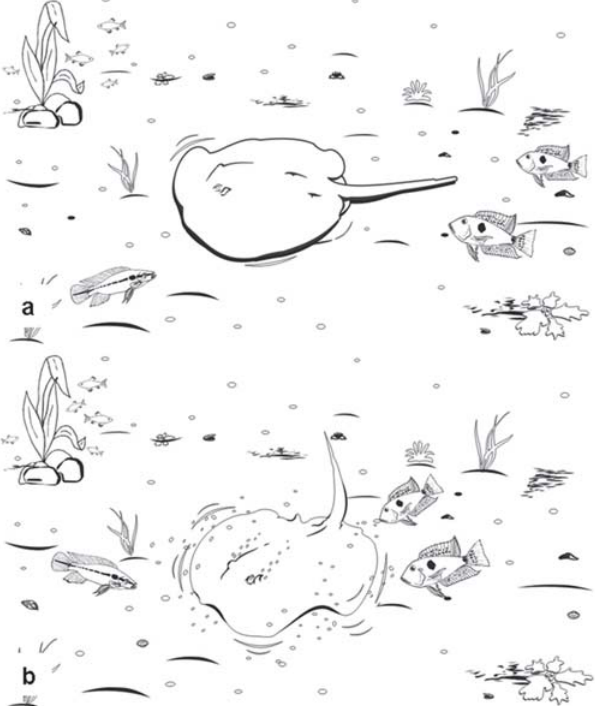
Fig. 2. Association between a foraging freshwater ray ( Potamotrygon falkneri ) and two species of cichlid fishes ( Crenicichla britskii on the left and Geophagus proximus on the right). The ray settles close to the bottom, begins to undulate the disc and stir the substrate, which cause the cichlid to approach (a); as the ray proceeds foraging and forms a fine sediment cloud, the cichlids hover head-down close to the disc and watches potential prey to be uncovered by the ray’s movements